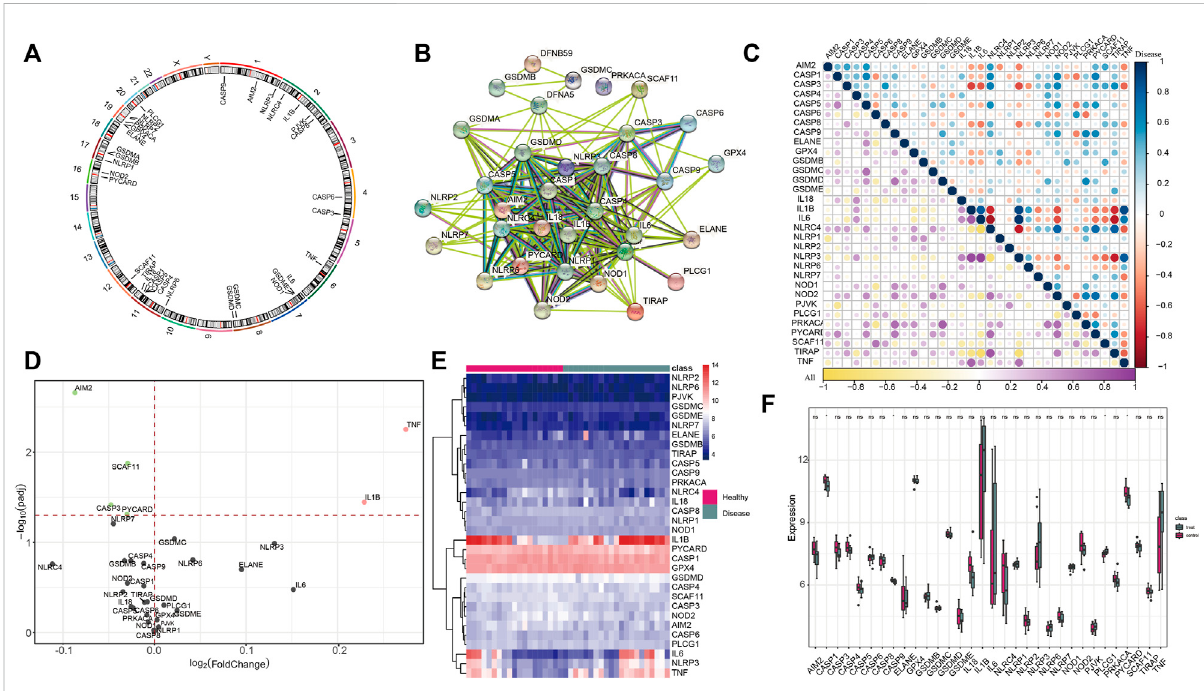
FIGURE 1 Identi fi cation of DEGs between healthy and IS samples. (A) Distribution of 33 PRGs on chromosomes. (B) Thirty-three PRG protein – protein interactions are presented. (C) Correlations among the expression of pyroptosis genes in all healthy and IS samples. (D) Volcano plot shows the summary of expression-changing information of 33 PRGs between healthy and IS samples. (E) Heatmap plot demonstrates the transcriptome expression status of 33 PRGs between healthy and IS samples. Blue: low expression level; red: high expression level. (F) Box plot demonstrates the transcriptome expression status of 33 PRGs between healthy and IS